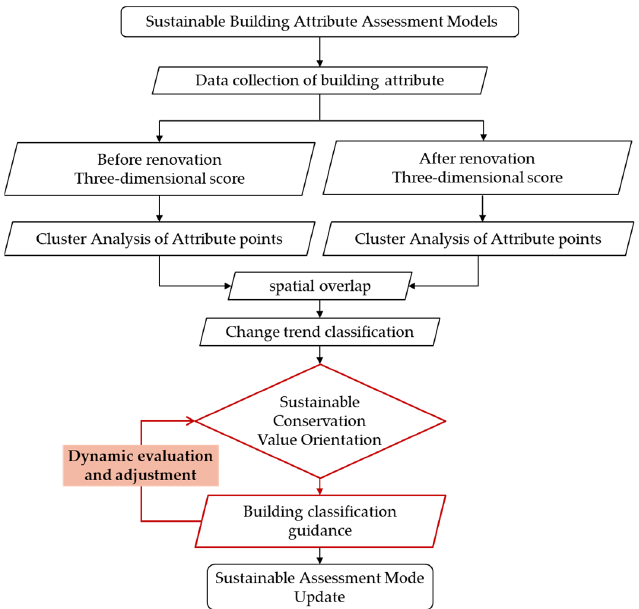
Figure 7. The research process in sustainable building attribute assessment model.